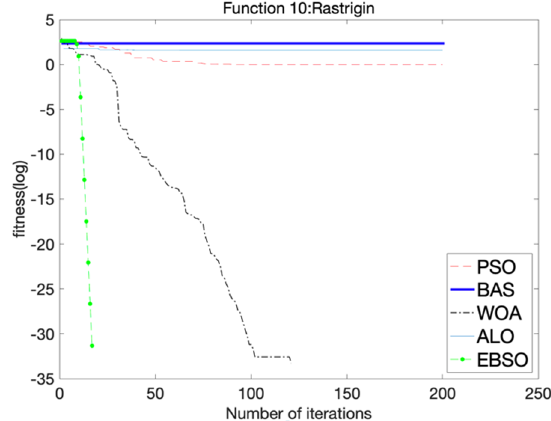
f iterative convergence graph. Figure 16. f 10 iterative convergence 10